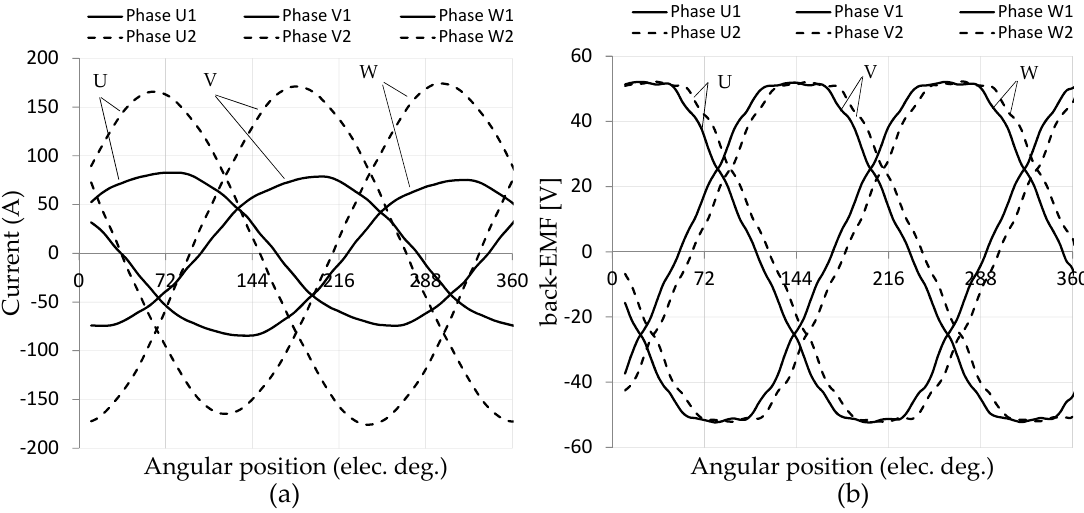
12 of 15 Figure 11. No-load air-gap flux density distribution, z-component. Both machines with misalignment effects are compared with a “healthy” machine: ( a ) AF PMSM with 1533 normalized air-gap offset; ( b ) machine with 10 electrical degrees stator offset. In the case of stator misalignment with 10 electrical degrees of stator offset, the z-component of the flux density field through the mechanical air-gap leads to marginal changes in local minimums